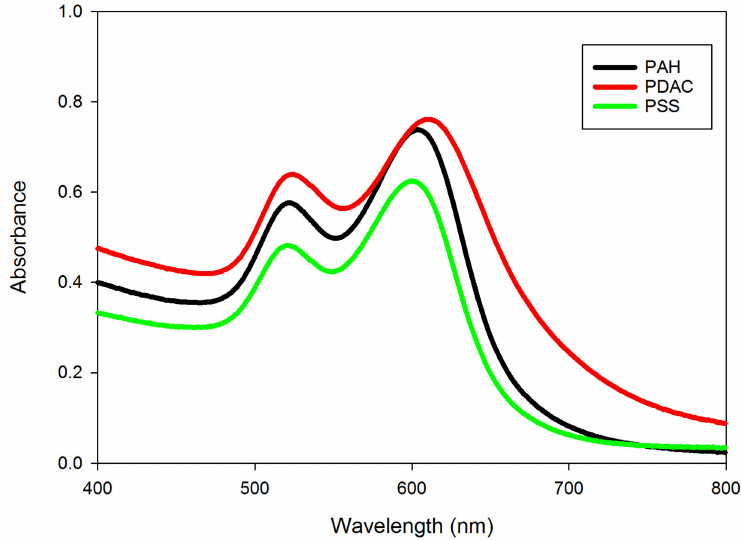
Figure 2. Absorption spectra of GNRs modified with PSS, PAH, and PDAC after functionalization.